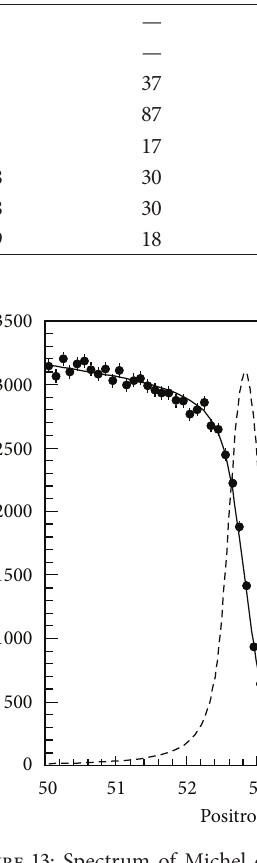
spectrum and the detector acceptance, as shown in Figure